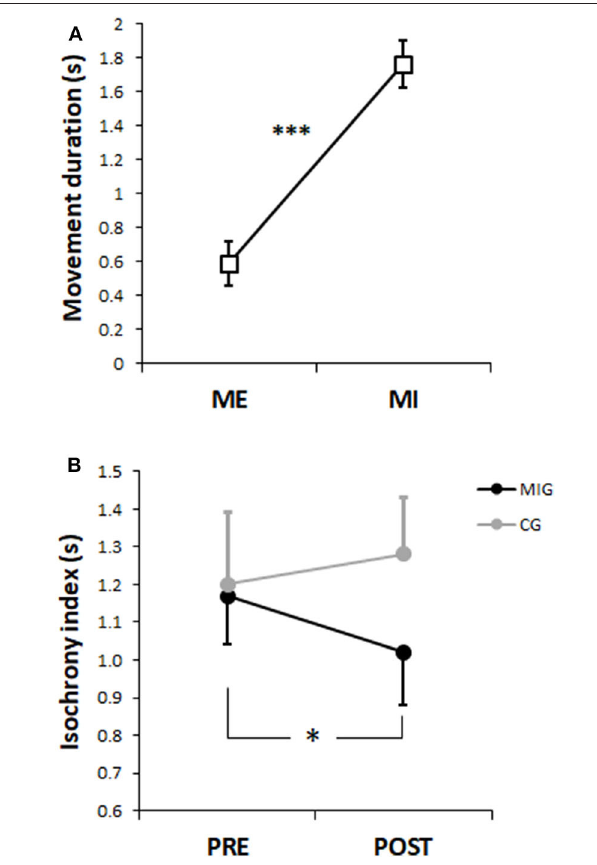
FIGURE 2 | (A) Mean values of the duration (s) of executed (ME) and imagined (MI) movements. (B) Isochrony index mean values of the Motor Imagery Group (MIG—black circles) and Control Group (CG—gray circles). Error bars indicates standard errors. * p < 0.05, *** p < 0.001.